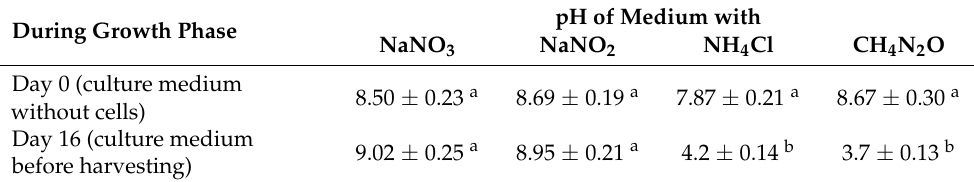
Table 3. Variation of pH in culture medium.